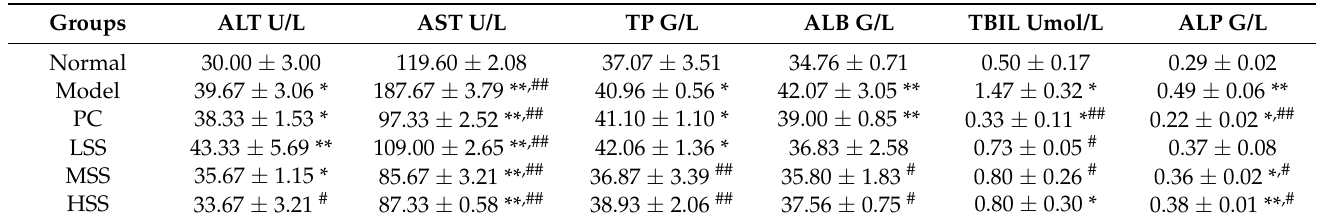
Table 2. Effects of oral SS administration on serum liver functional enzymes in T2D